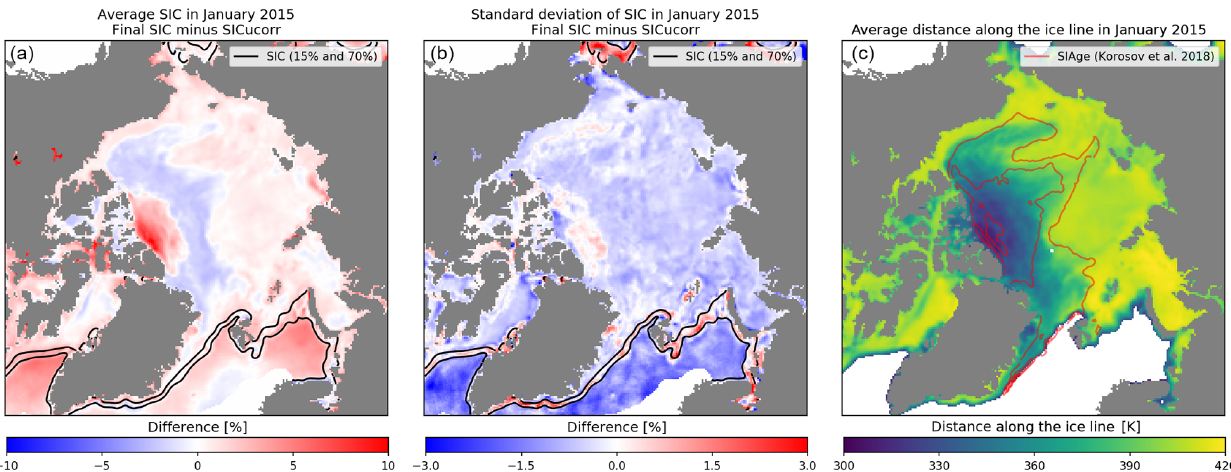
Figure 5. (a, b) Difference maps between the January 2015 mean (a) and temporal variability (b) of the final SIC and the uncorrected SIC (SIC ucorr ) in the Arctic Ocean. Black solid lines are at the 15% and 70% SIC levels (marginal ice zone). (c) January 2015 mean distance along the ice line (DAL) values, red lines are transitions between first-year sea ice, second-year sea ice, and older sea ice from Korosov et al.